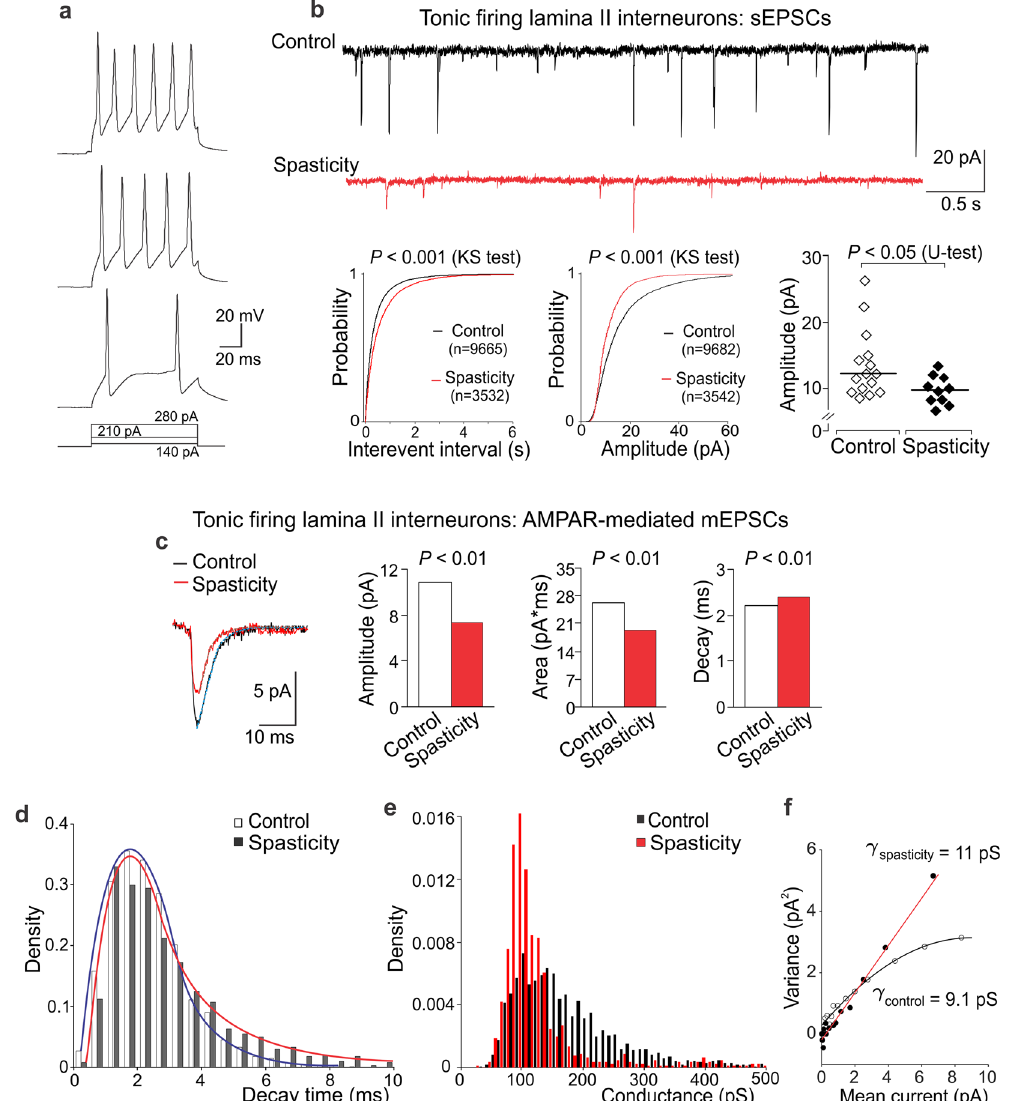
Figure 4. The reduced excitatory drive and diminished postsynaptic AMPAR-currents in TFNs post-SCI. ( a ) Examples of the current-clamp recordings of typical firing discharge of TFNs in response to depolarizing currents of increased intensity (indicated on the bottom). ( b ) Representative voltage-clamp recordings of sEPSCs (Vh = − 70 mV) in control and spasticity (upper rows) and cumulative probability plots for the inter- event interval and the amplitude of sEPSCs (lower left) with the Kolmogorov-Smirnov (KS) test significance indicated. The scatter plots for the median current amplitude (lower right) in control and spasticity, estimated for each individual TFN (n = 15 cells in control and 10 cells in spasticity). The Mann-Whitney U-test significance is indicated. ( c ) The averaged AMPAR-mediated mEPSCs (left) and summary of the median current amplitude, the area, and the decay kinetics (right) in TFNs in control and spasticity. The Mann-Whitney U-test significance is indicated. ( d , e ) The probability density functions of the decay time of AMPAR-mediated currents ( d ) and the estimated AMPAR-conductance ( e ) in TFNs in control and spasticity. ( f ) The single- channel conductance of postsynaptic AMPARs in TFNs in control (n = 5 cells, 711 mEPSCs) and spasticity (n = 6 cells, 120